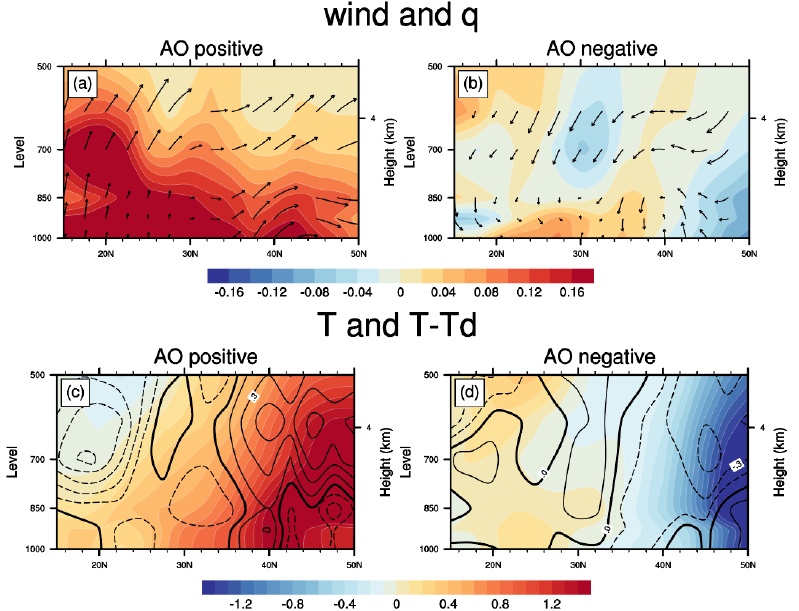
Figure 9. Latitude–height cross-sections of wind (vector), water vapor (shaded) anomaly fields in winter (zonal average of 110–120° E) for the ( a ) positive AO and ( b ) negative AO (vector, V unit: m s -1 ; ω unit: −0.01Pa s -1 ; specific humidity unit: g/kg).( c , d ) are the same as ( a , b ), but for the T (shaded) and T-Td (contour) anomaly fields (unit: K).